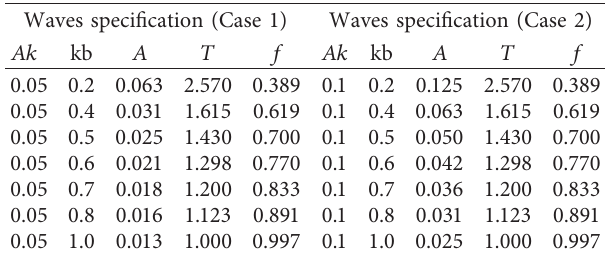
Table 3: Waves specifications.